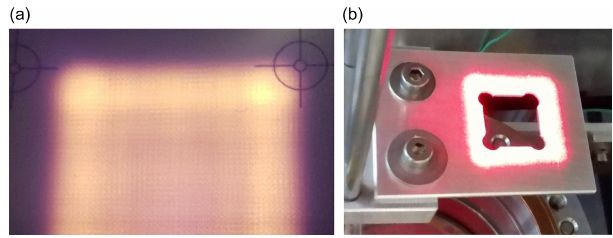
Figure 2. (a) Cross section of the laser beam (at 1530nm) af- ter passing through the homogenization unit projected on a VRC4 IR detector card showing somewhat higher power densities at the edges. (b) Mask used to further shape the beam. The beam size of the visible trace laser is about 5% larger than that of the NIR